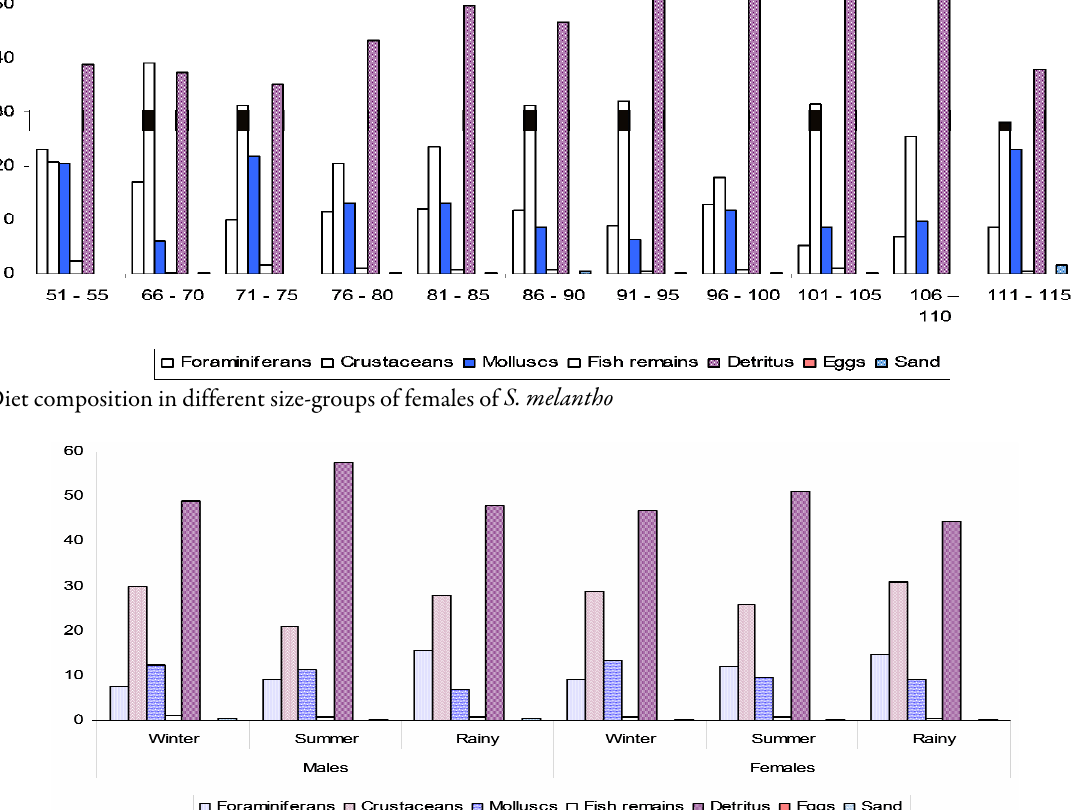
Fig. 7. Diet composition of males and females of S. melantho in different